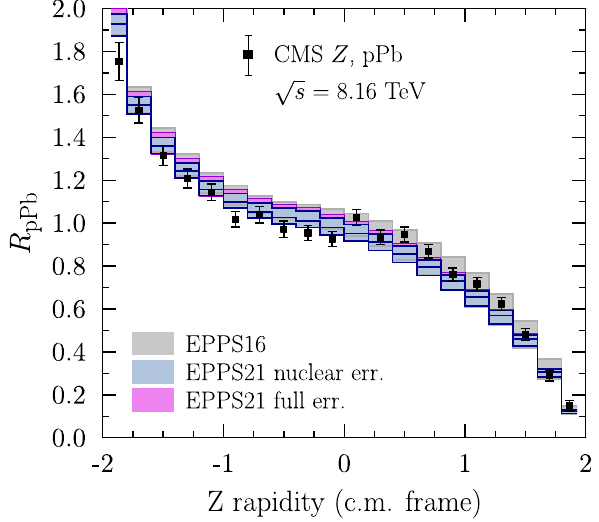
Fig. 17 The CMS 8 . 16TeV Z-boson data [99,100] for nuclear modi- fication R pPb compared with the EPPS21 fit. The solid blue lines show our central results, inner blue bands the nuclear uncertainties, and the purple bands the total uncertainty. The data have been normalized by a factor of 0.951 which is the optimal normalization with EPPS21. The grey bands correspond to the EPPS16